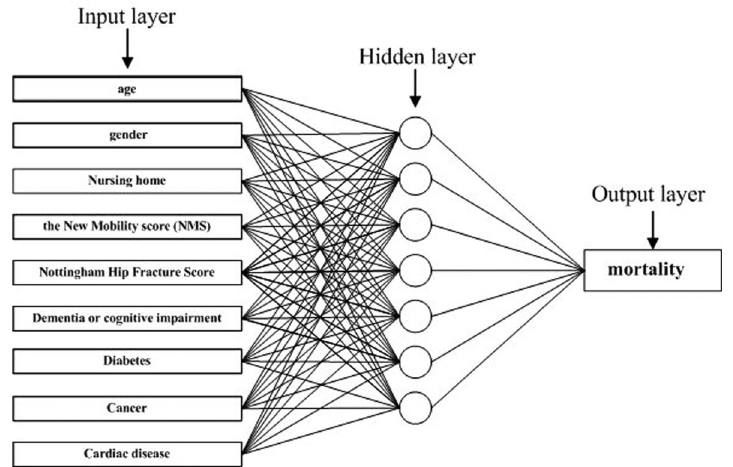
Figure 2. Schematic representation showing the structure of the artificial neural network models, which have 8 input nodes, 6 nodes in hidden layer, and 1 output node, which represents 1- year mortality in elderly patients with intertro- chanteric